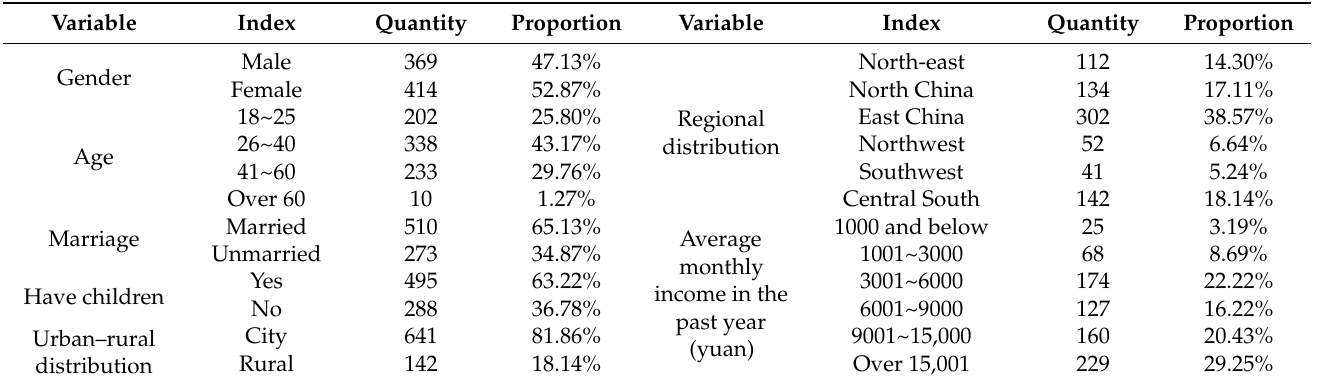
Table 2. Basic statistical characteristics of